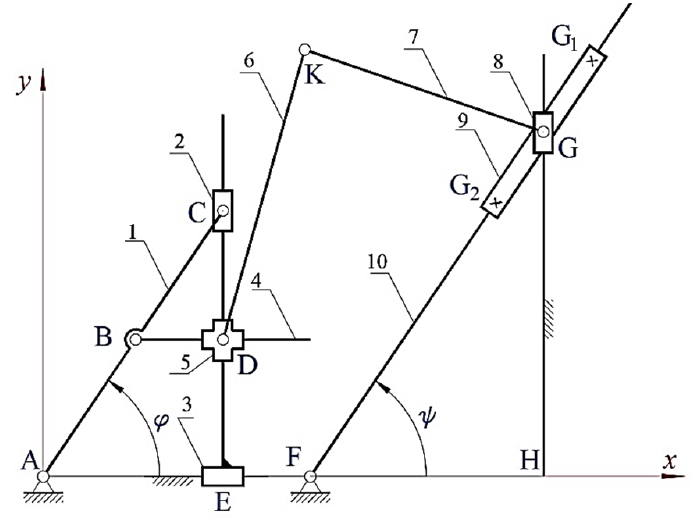
Figure 1. Connecting rod curve generating mechanism.